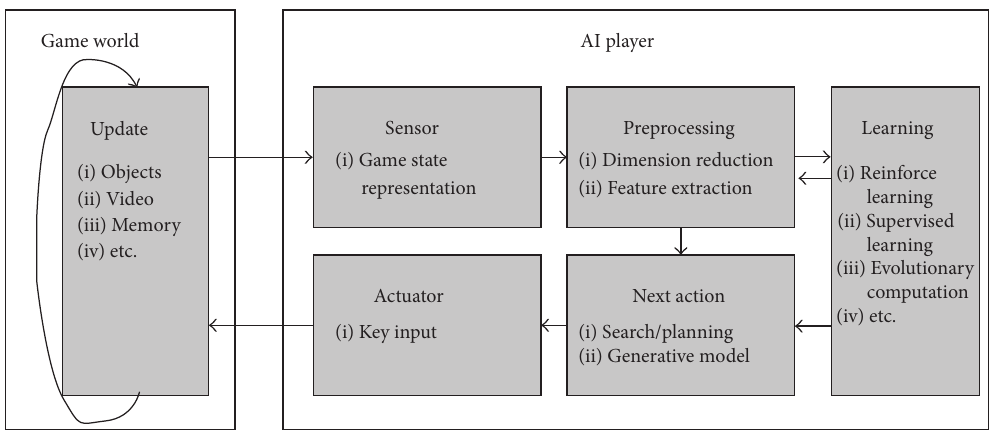
Figure 4: Overview of the GVGP decision process and research